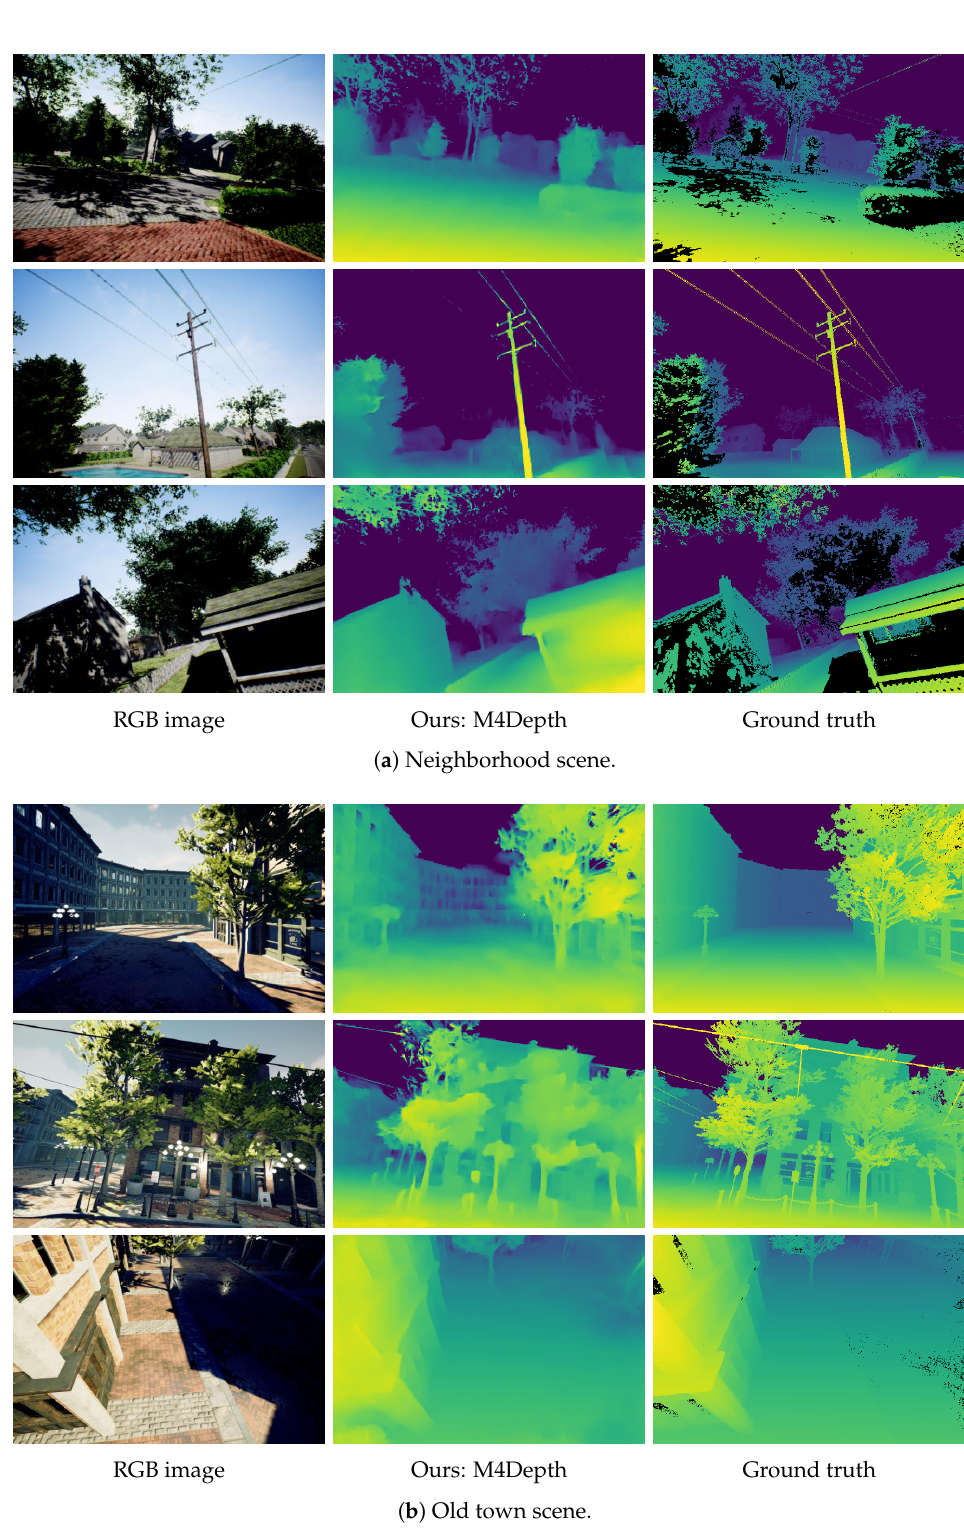
Figure 7. Samples of depth maps produced in generalization on urban scenes of the TartanAir dataset by M4Depth with six levels trained on Mid-Air and fine-tuned on KITTI. Black areas in the ground truths correspond to pixels with no color information in the RGB